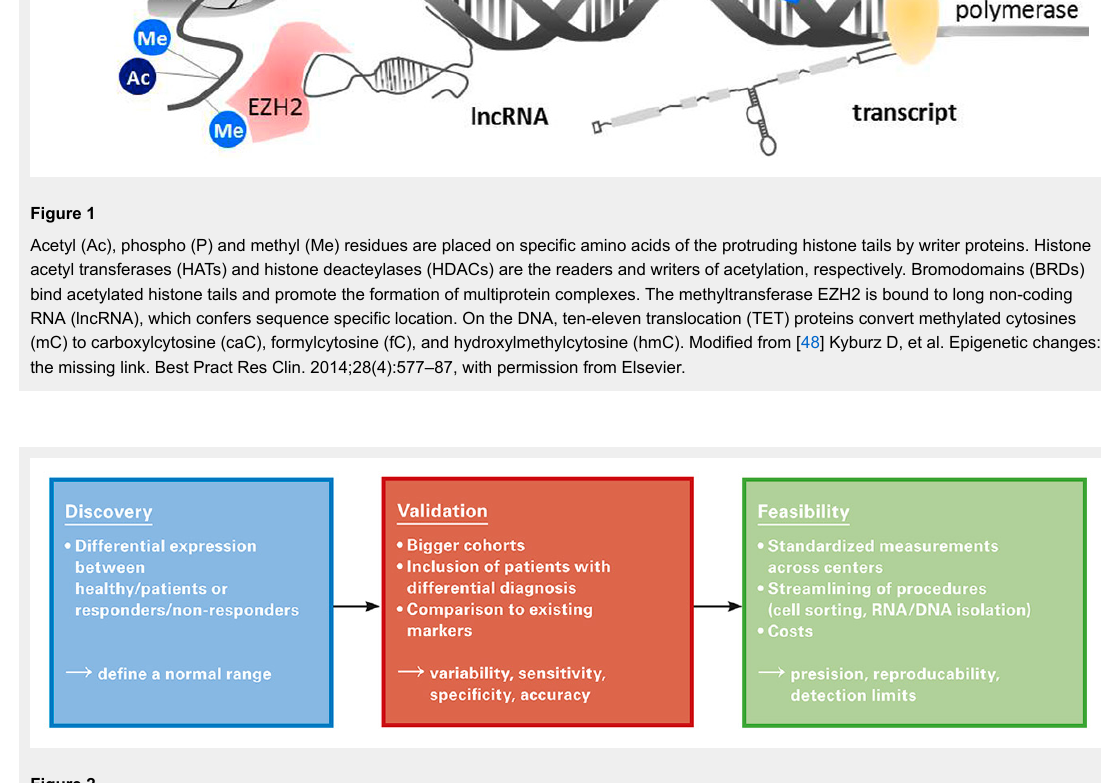
The development of a clinically useful biomarker requires several separate studies and analysis. Unfortunately in rheumatology most of the biomarker studies are in the discovery phase, but have neither been validated nor tested for their